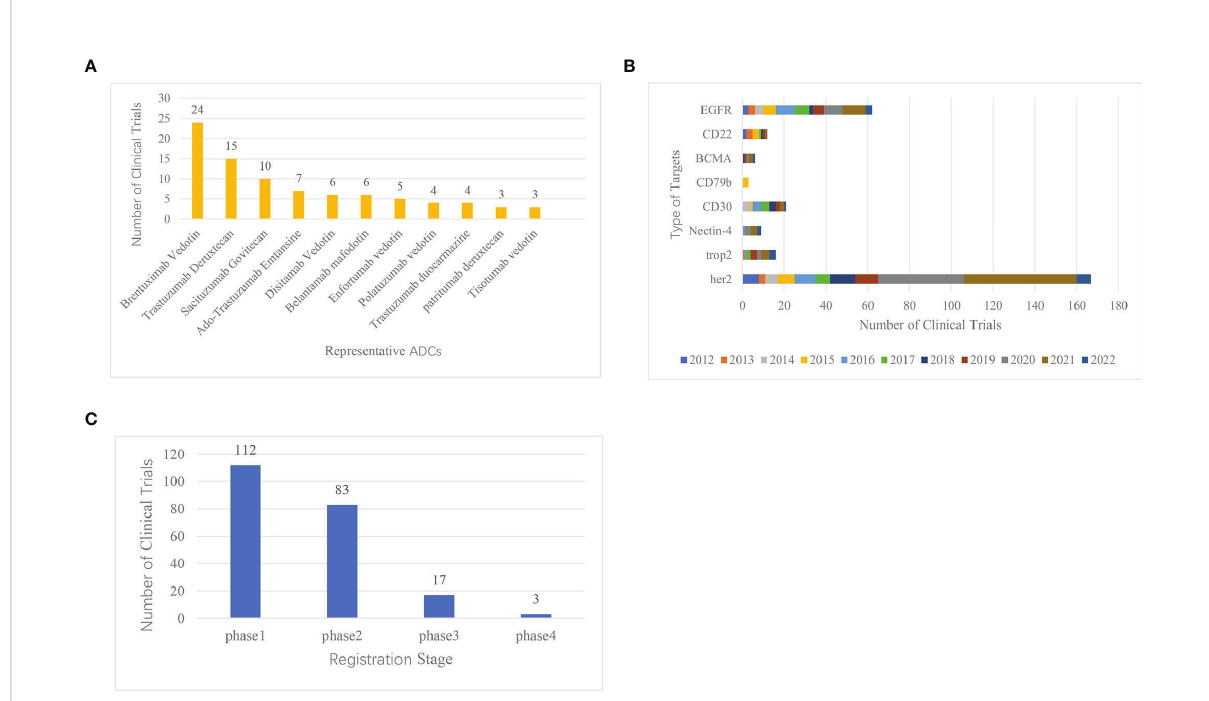
FIGURE 3 Clinical registration trials of ADCs ranked by representative drugs, common target, and clinical stages. (A) Ranking of clinical trials of representative ADCs research. (B) Histogram of common targets of ADCs. (C) Distribution of clinical trial registration stages in ADCs research.